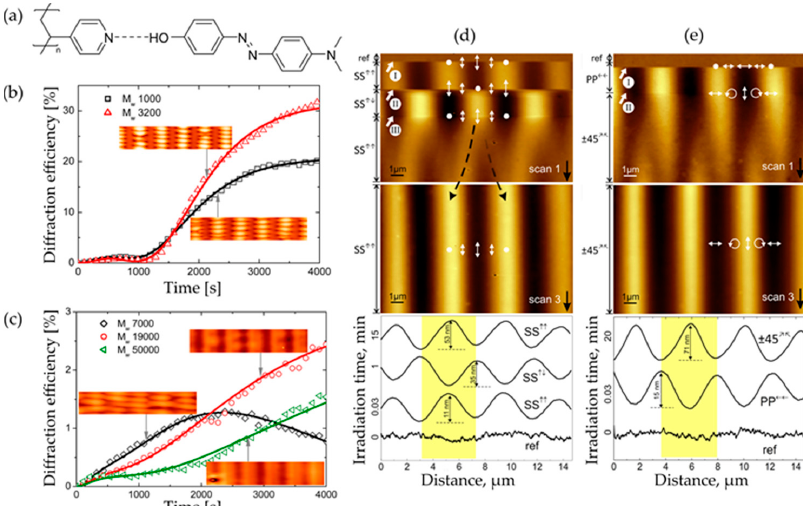
Figure 5. ( a ) Chemical structure of the hydrogen-bonded supramolecular azobenzene, P4VP(OH- DMA) complex; ( b , c ) Diffraction efficiency as a function of time using s-s polarization